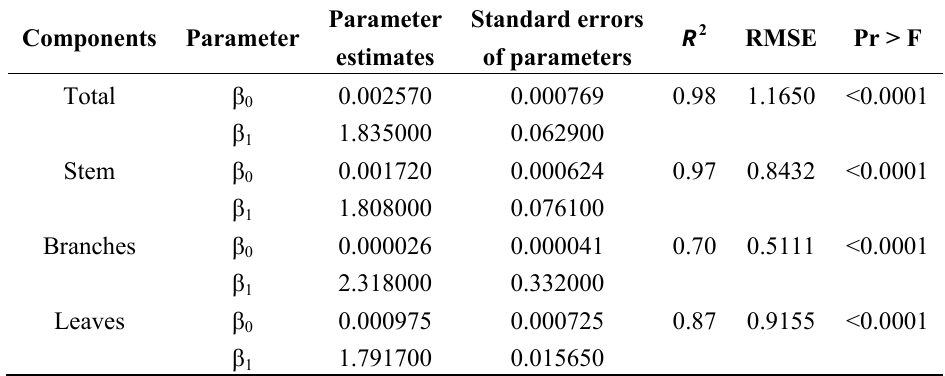
Table 6. Estimated parameters of equation (1) for estimating the dry weight of hybrid poplar sprouts growing on former farmland.